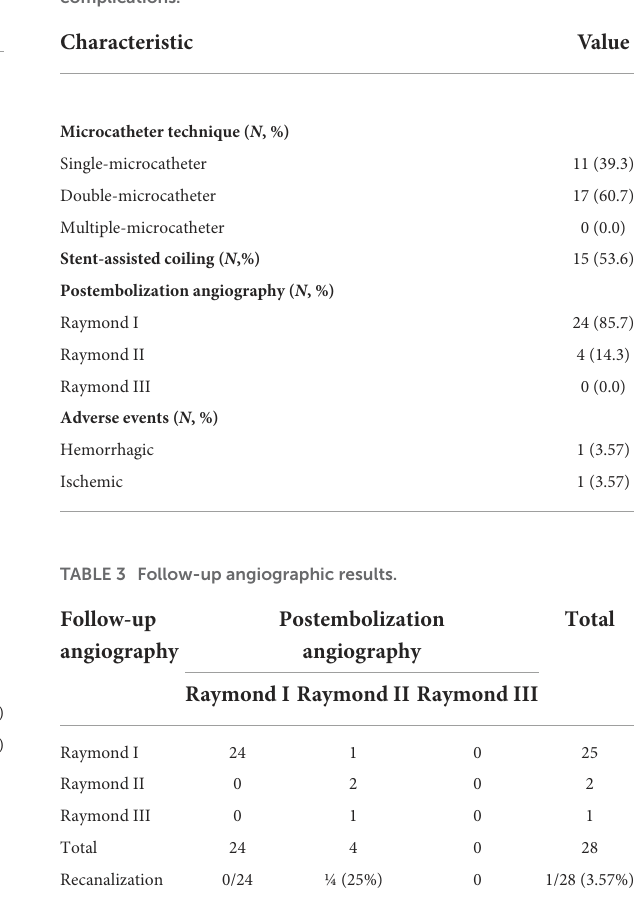
TABLE 1 Patient demographics and aneurysm characteristics. TABLE 2 Immediate post procedural angiographic results and clinical complications.